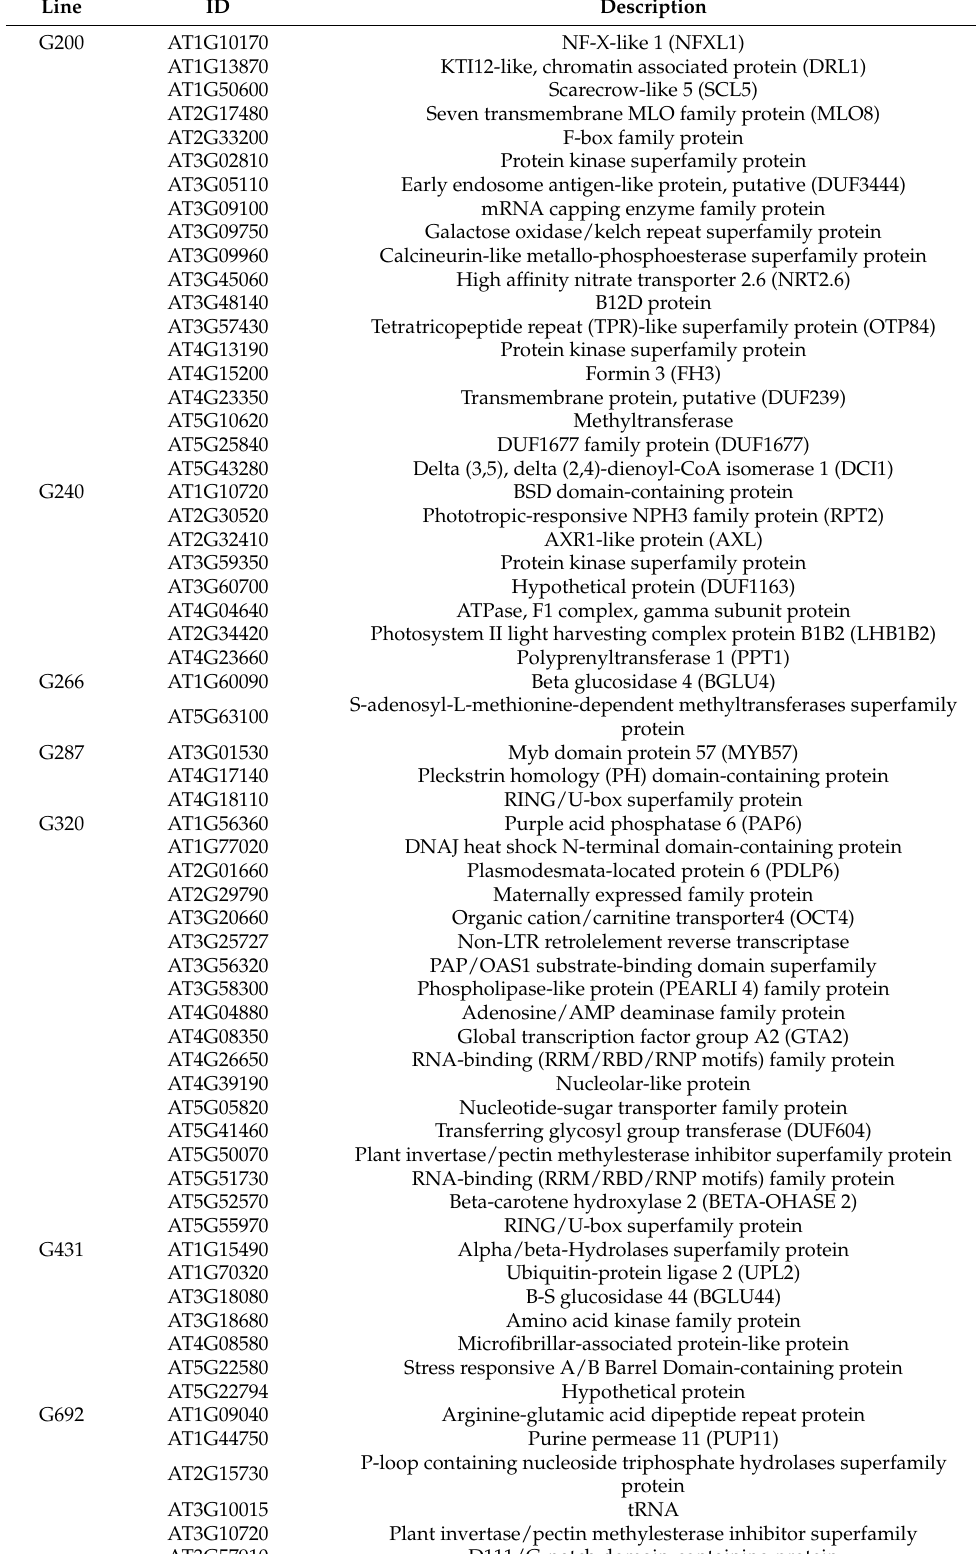
Table 2. Affected genes with non-synonymous a , UTR and splice region mutations the re-sequenced